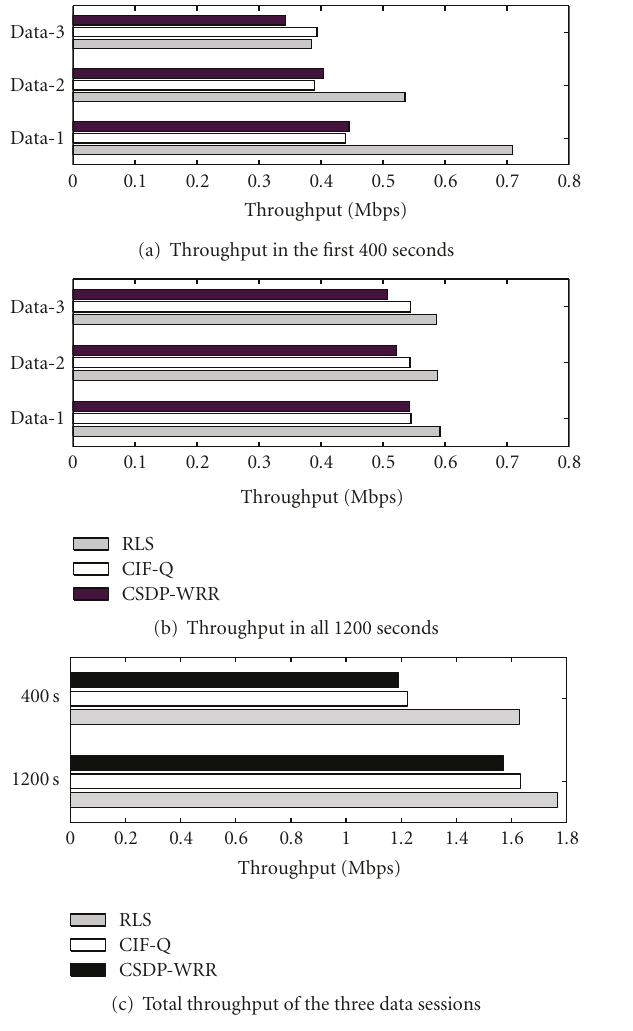
Figure 8: Comparison on throughput of nonrealtime sessions.